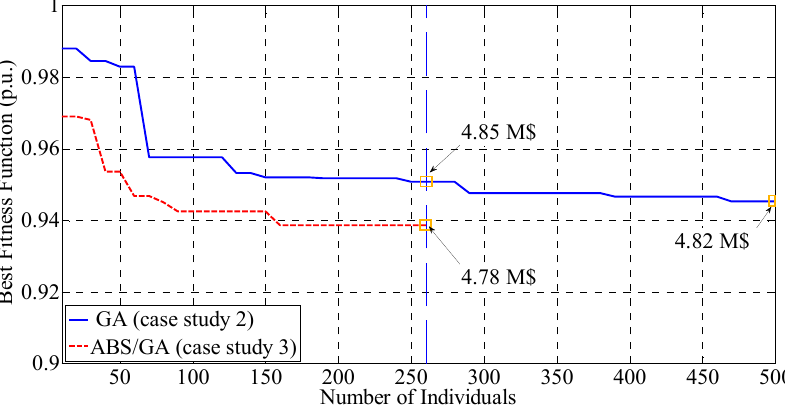
Figure 15. Case Study 3: Reactive power of one DESS and one genetic algorithm (DG) during the last typical day.